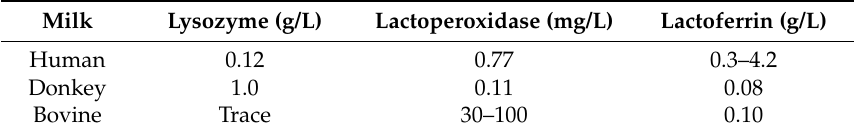
Table 8. Amount of the three main antimicrobial factors in human, bovine, and donkey milk.